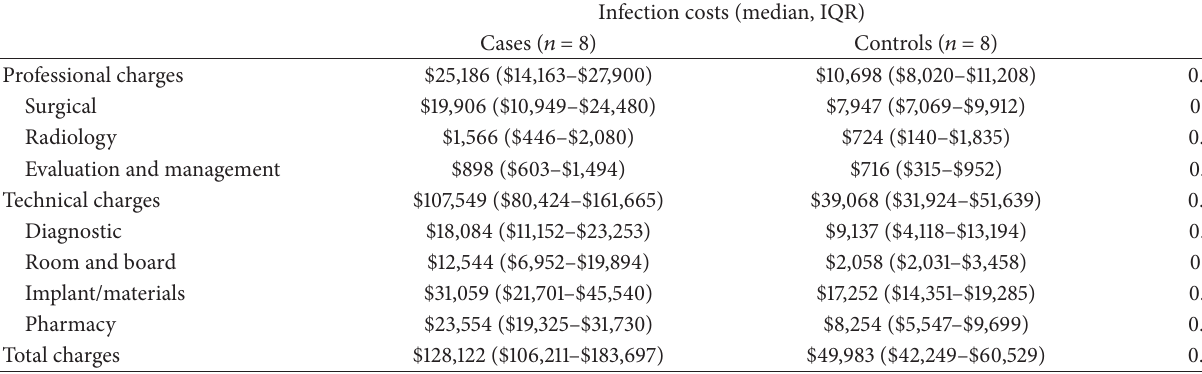
Table 4: Case versus control comparison for infection costs.